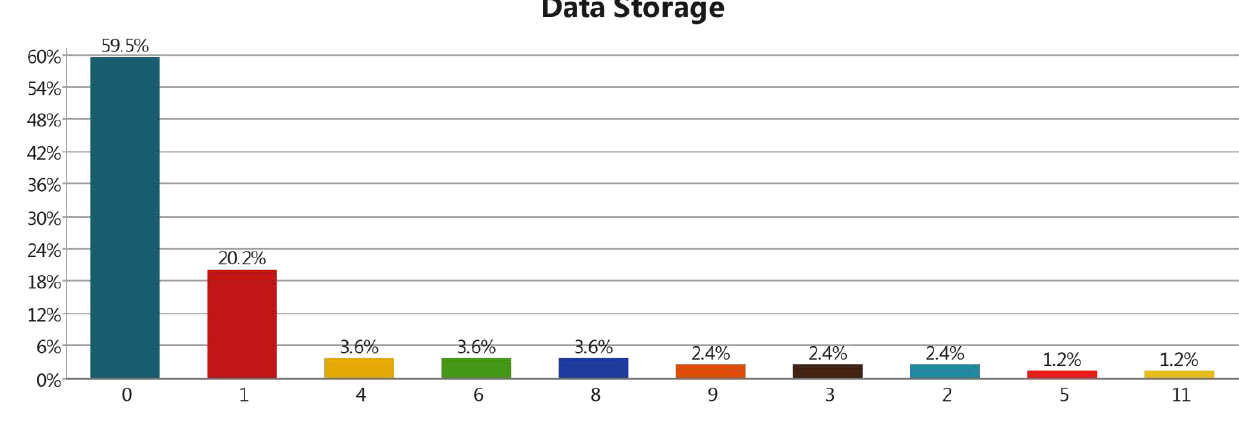
Figure 11. Potential determinants of IoT—Data storage.